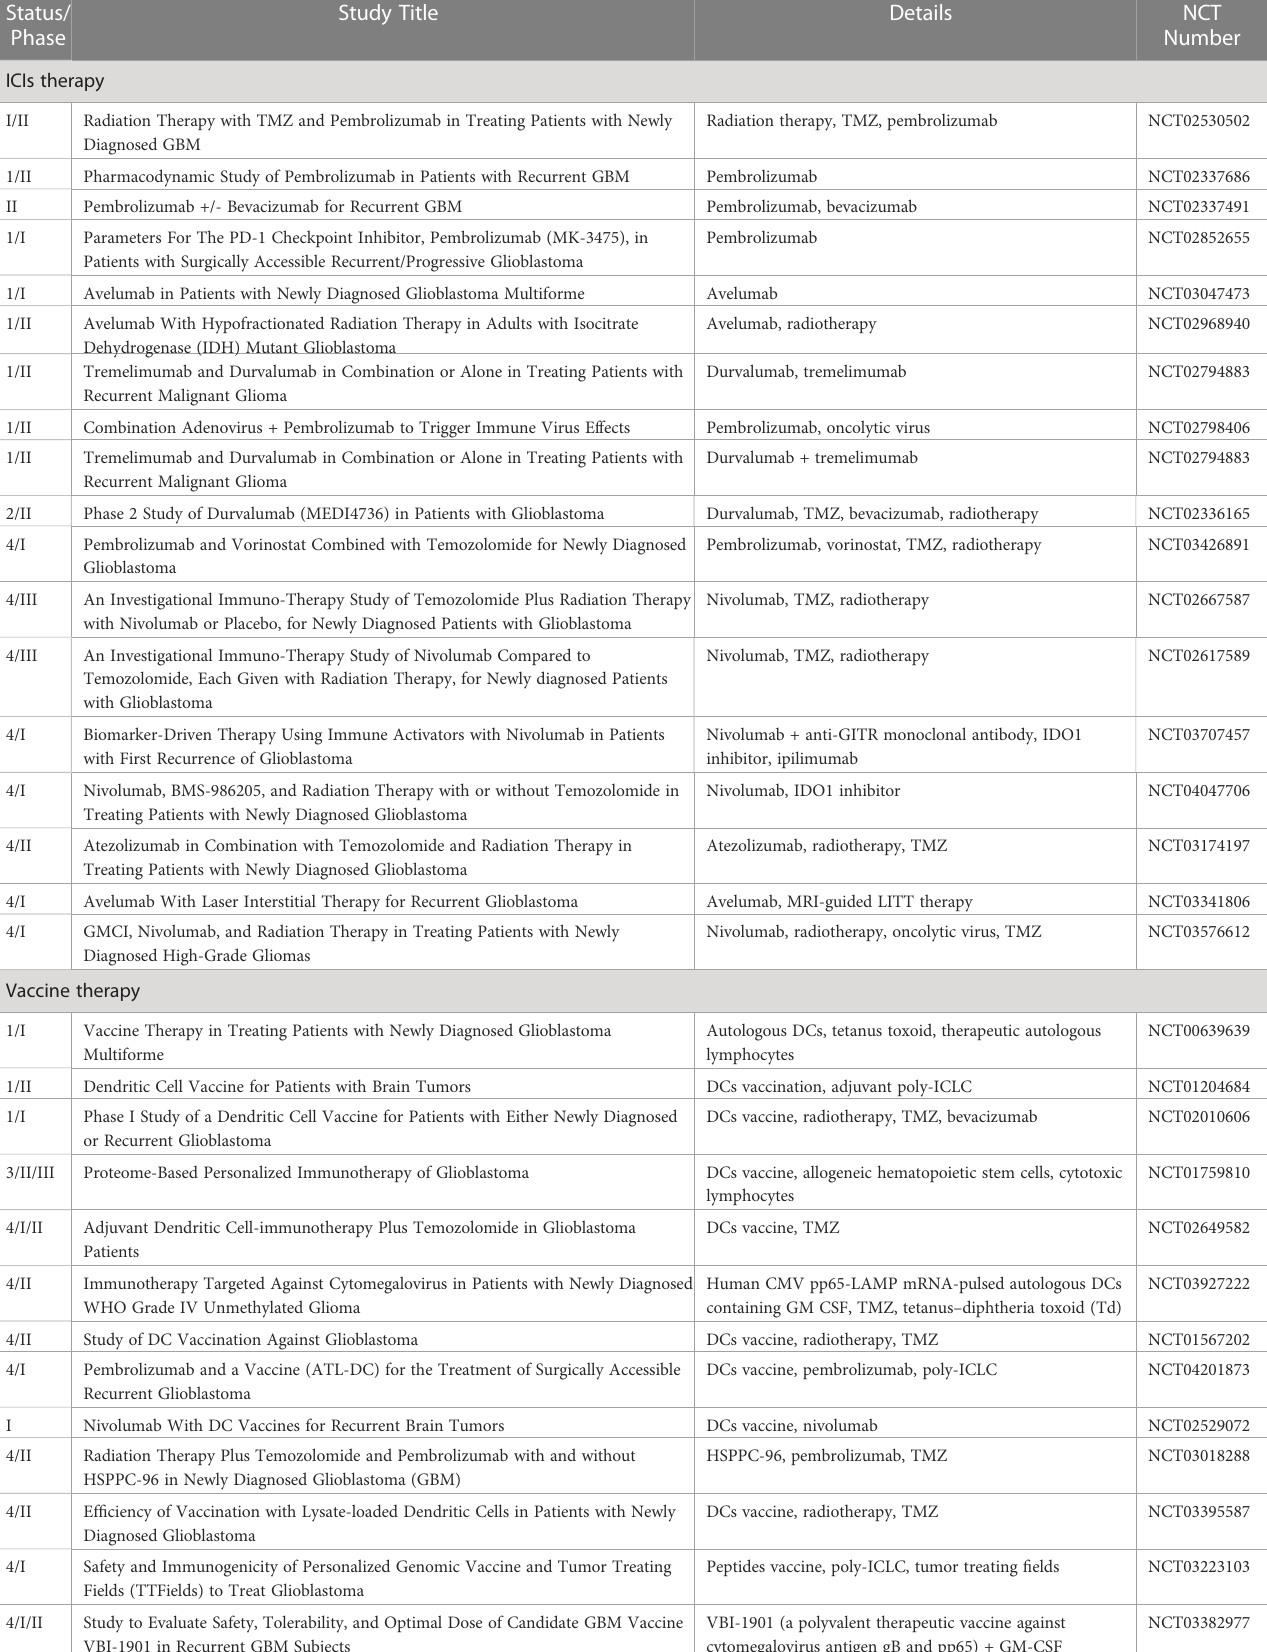
TABLE 1 Ongoing clinical trials involving immune checkpoint inhibitors (ICIs), vaccines, and adaptive T cells.